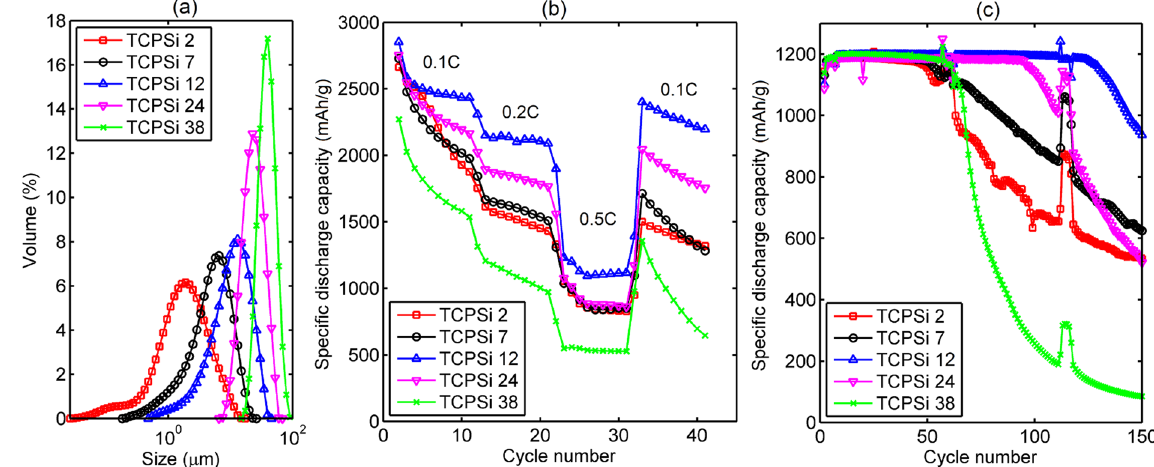
Figure 2. PSi particle size distributions and corresponding electrochemical cycling results for different sizes. ( a ) Particle size distributions for the TCPSi samples. ( b ) Galvanostatic rate capability results for the TCPSi samples. Mass loading of silicon was 1.1 mg/cm 2 . ( c ) Galvanostatic capacity results with a limited capacity of 1200 mAh/g. Cycling was done periodically: 5 × 0.1 C + 50 × 0.2 C while 1 C equals to 4200 mA/g. Mass loading of silicon was 0.8 mg/cm 2